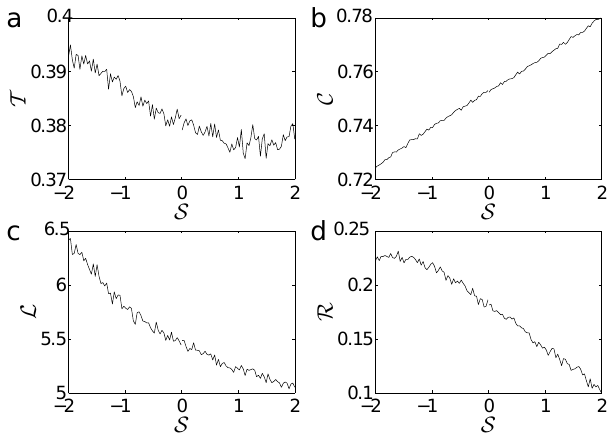
Figure A1. VG characteristics (a) transitivity T , (b) global clus- tering coefficient C , (c) average path length, L and (d) assortativ- ity coefficient R for gamma-distributed white noise with tunable skewness S (time series length T = 1667, ensemble averages over 50 independent